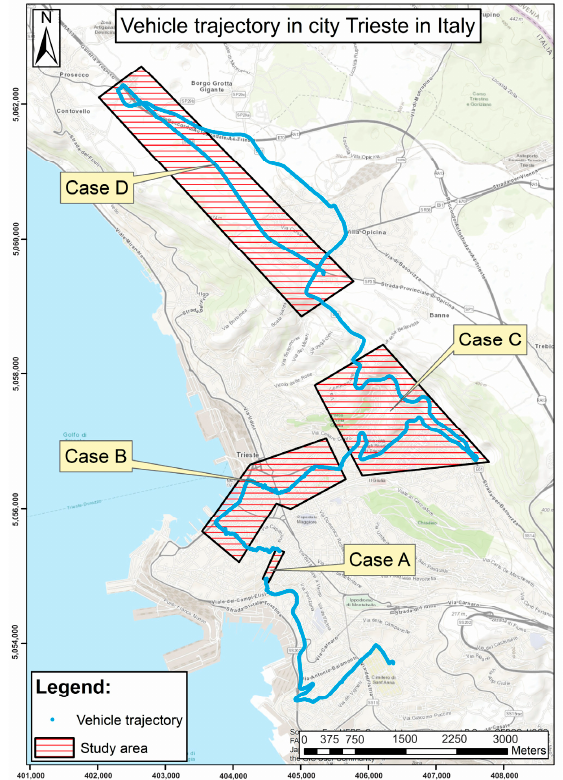
Figure 4. The surveyed area, the city of Trieste and nearby region, Italy.